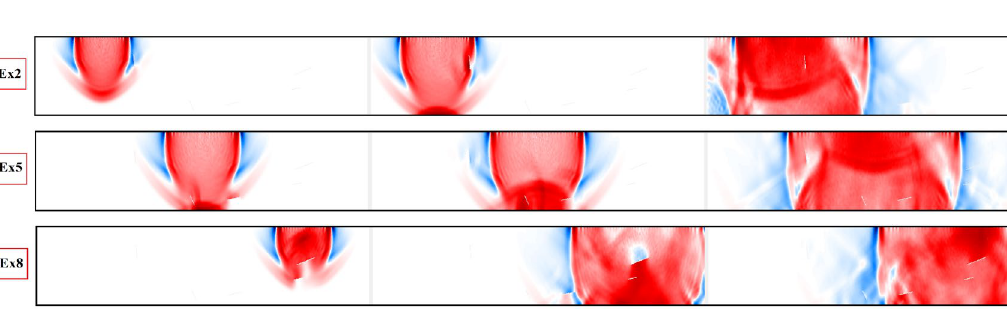
Figure 11. Plotted displacement wave fields in different time steps for each dynamic excitation condition: Ex2, Ex5, and Ex8. For better visualisation of the wave disturbance and dispersion different time steps are